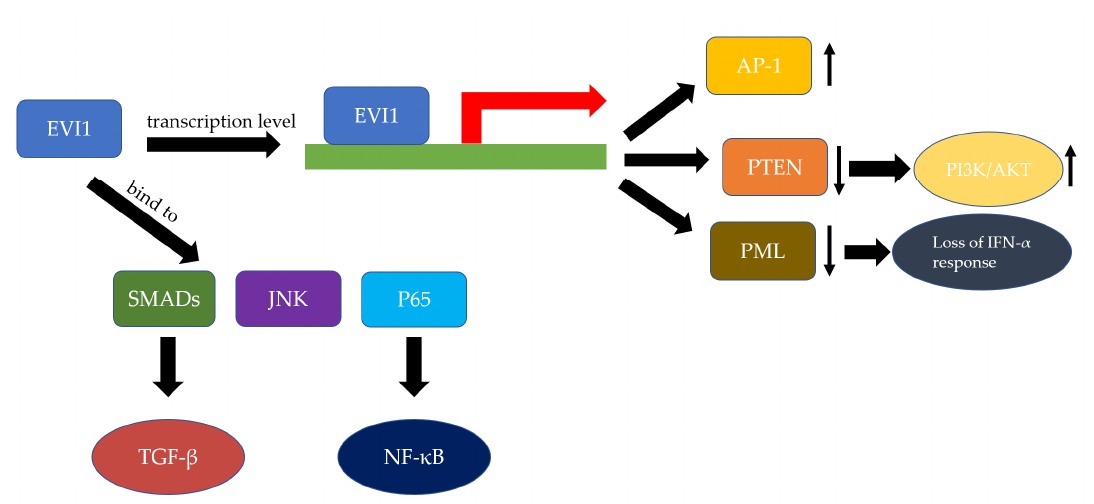
Figure 4. Downstream signaling pathways of EVI1 . Known downstream signaling pathways of EVI1 include the PTEN / PI3K / AKT, TGF- β signaling, JNK and NF-kB pathways. The green bar represents DNA and the red arrow indicates the transcription start site.